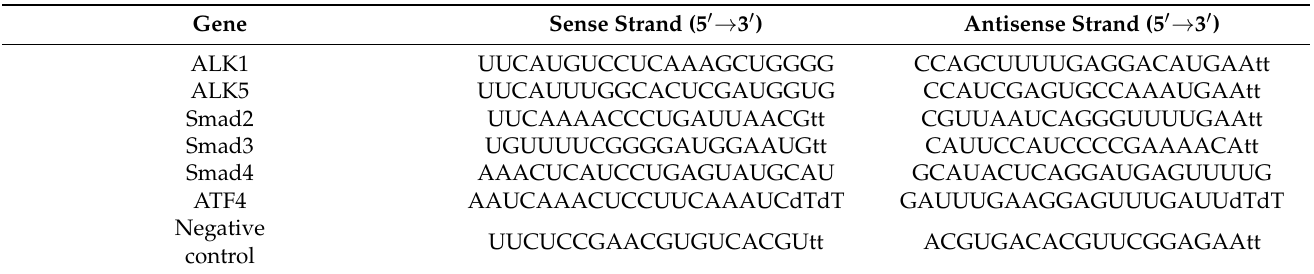
Table 1. Sequences of siRNA sense and antisense strands. Gene Sense Strand (5 (cid:48) → 3 (cid:48) ) Antisense Strand (5 (cid:48) → 3 (cid:48)